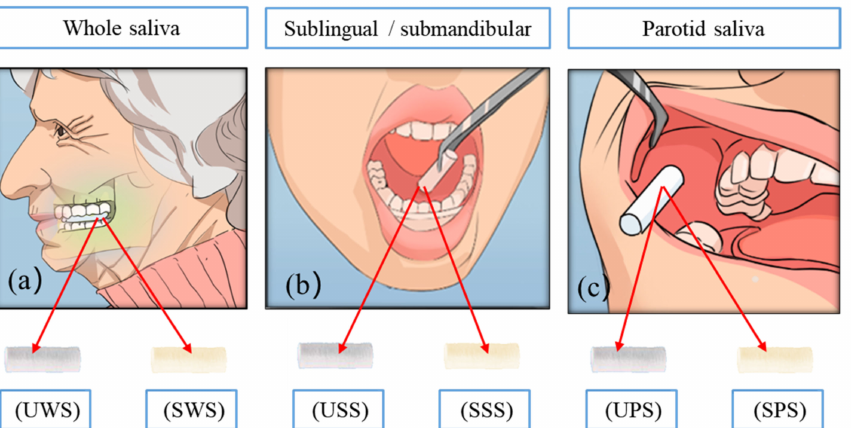
Figure 1. Six methods for collecting saliva samples, ( a ) UWS/SWS: the swab in the test tube was taken out and put in the mouth to chew for 3 min, ( b ) USS/SSS: the swab was put under the tongue and it was taken out after 3 min, ( c ) UPS/SPS: the swab was placed near the left parotid duct and it was taken out after 3